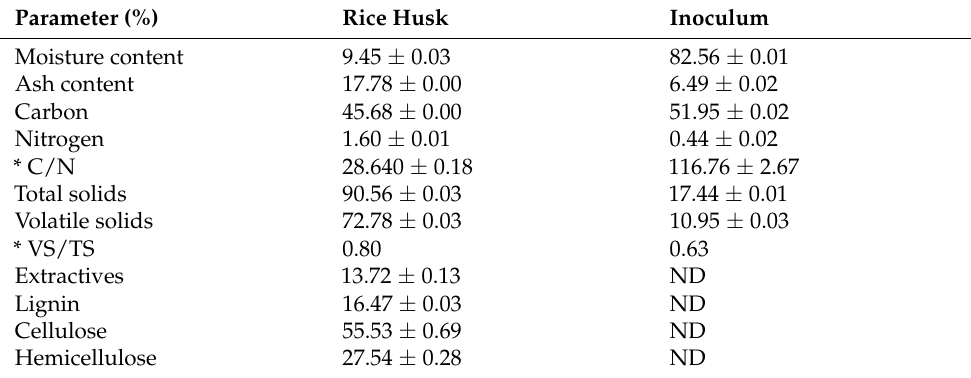
Table 1. Physicochemical properties of raw rice